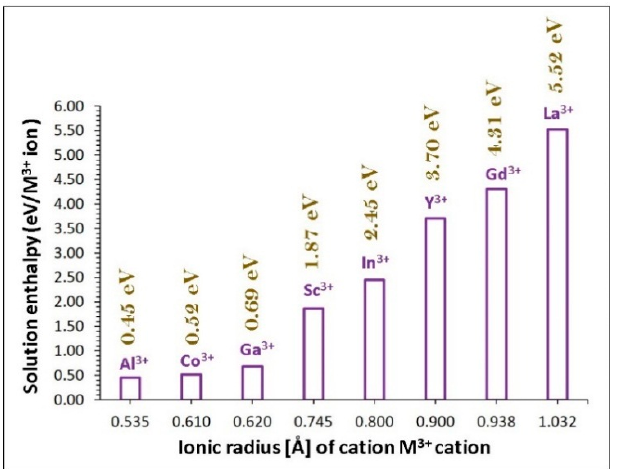
Figure 5. Enthalpy of solution of R 2 O 3 (R = Al, Co, Ga, Sc, In, Y, Gd and La) with respect to the R 3+ ionic radius in Li 2 MnO 3 .